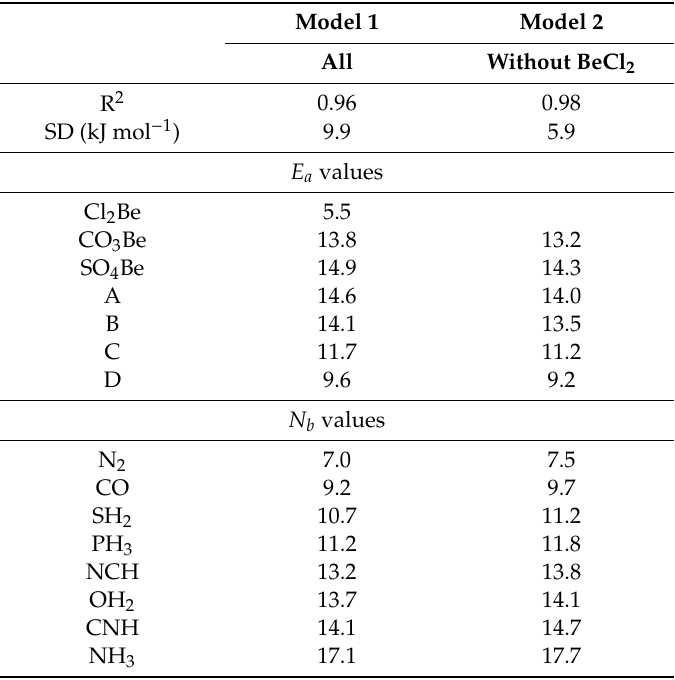
Table 5. Statistical values and fitted